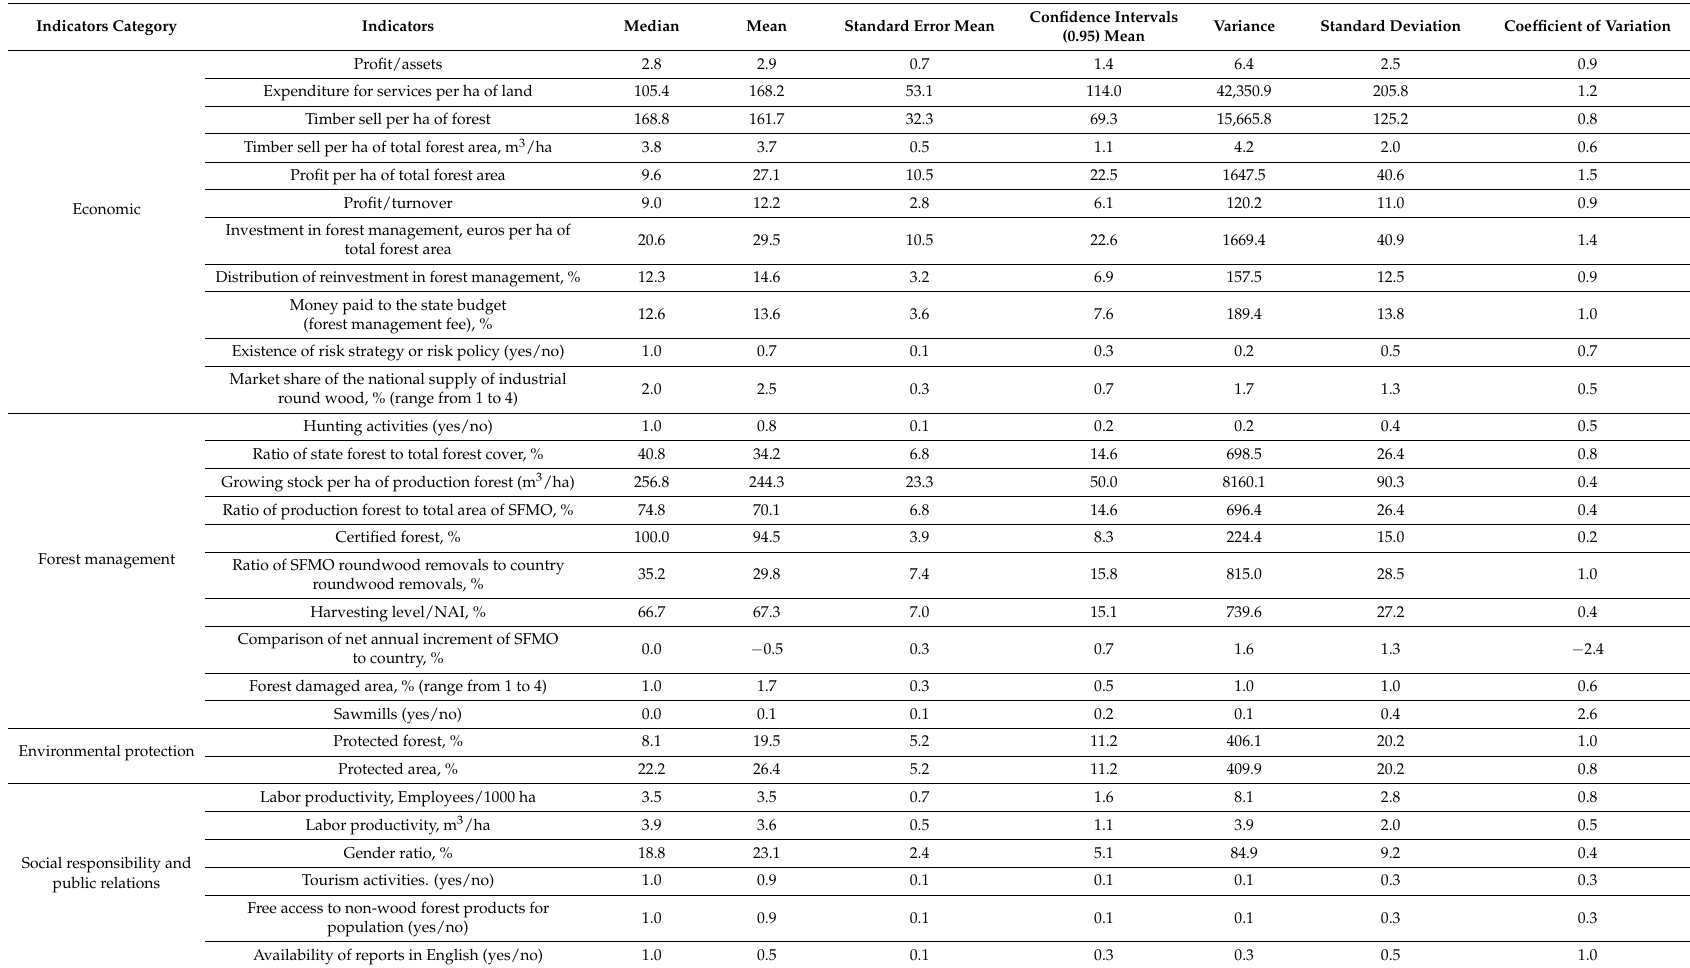
Table 4. List of indicators for cluster analysis and their basic statistical values (own